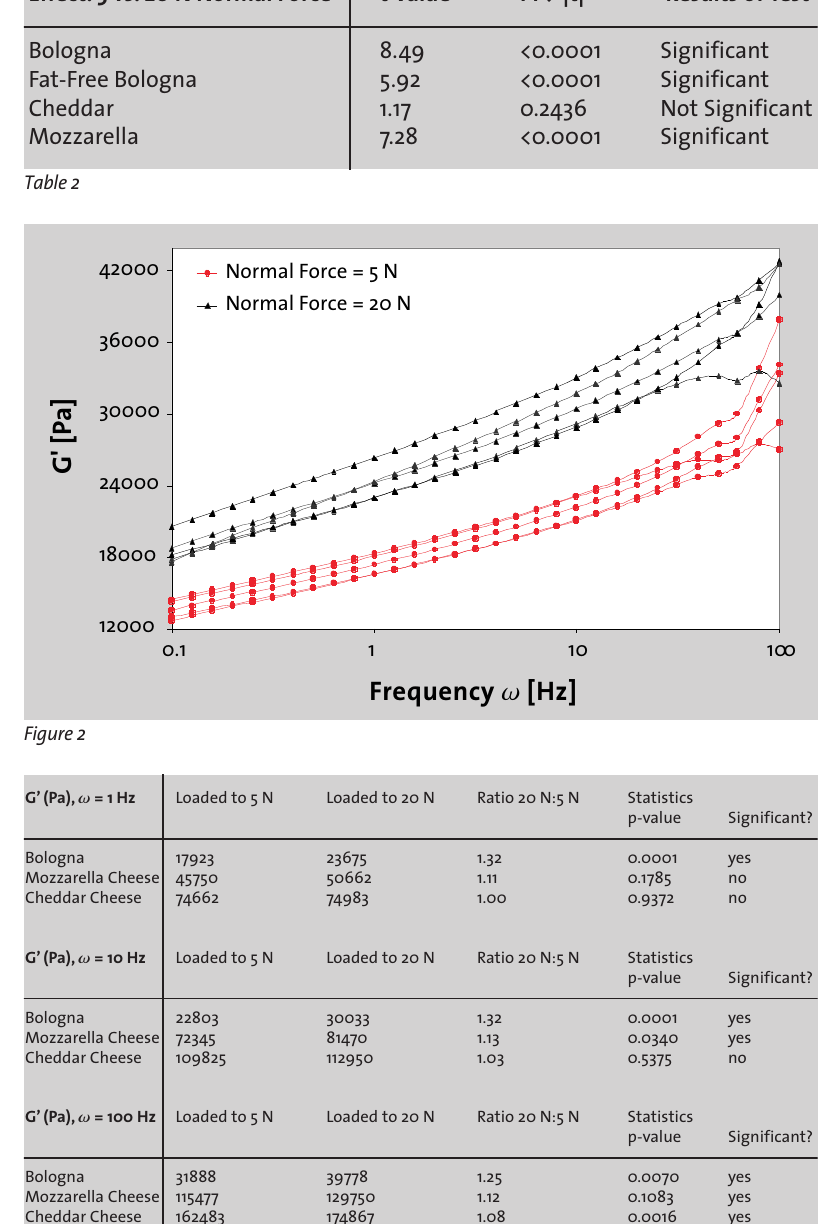
Table 2: Statistical analysis summary for average G’ values of semi-solid products (stress sweep at 10 Hz). Table 3: G’ values* of semi-solid samples loaded to 5 and 20 N at frequencies of 1, 10, and 100 Hz (frequency sweep, t = 20 Pa; *all values shown are the average of six samples).